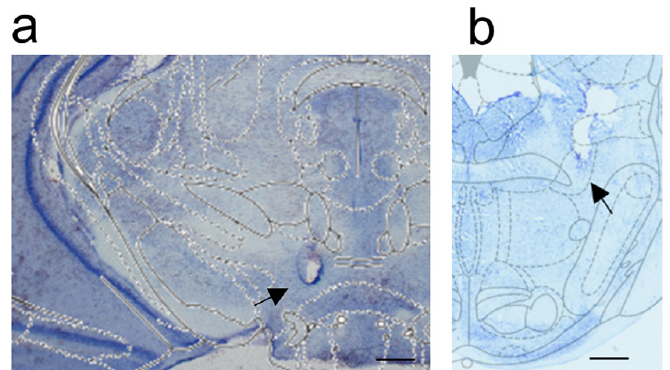
Figure 13. Photographs of selected brain sections from representative rats in the Mc-5 group stained with Nissl staining with localization of the electrode in the VTA (distance from bregma − 4.80 mm; black arrow—the position of the electrode tip) ( a ) and the cannula in the PPN (distance from bregma − 8.00 mm; black arrow—the position of the cannula tip) ( b ) with templates taken from the rat brain atlas [28] (a magnifier Stemi 508; Zeiss with camera Axiocam 105 color; Zeiss and with integrated software Zen Digital Imaging (version 3.2 (blue edition); Zeiss, magnification 2.5 × 10, scale bar 1 mm—right lower corner of the